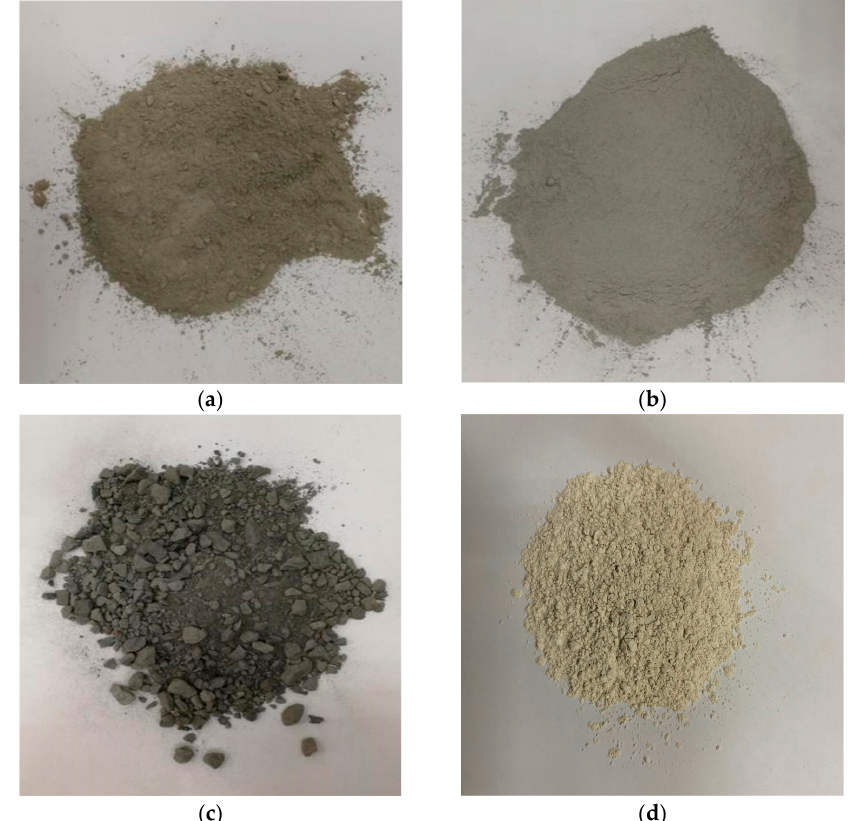
Figure 1. Raw materials. ( a ) Cement; ( b ) Fly ash; ( c ) Gangue; ( d ) Kaolin. The microscopic morphology of kaolin was analyzed by a scanning electron micros- copy (SEM) system. The powder sample was dipped on the conductive adhesive using a wooden stick, and the kaolin surface was plated with gold. The morphology of the sample was observed at 10,000× magnification, as shown in Figure 2a. The layered structure of kaolin particles is evident in the figure, and each block of kaolin particles is composed of many lamellar structures closely superimposed together, with clear edges and corners. The morphology of kaolin particles is irregular and the particle size is different, which is conducive to backfill the internal pores of CGFB samples, increasing its internal occlusal degree and improving its internal structure.